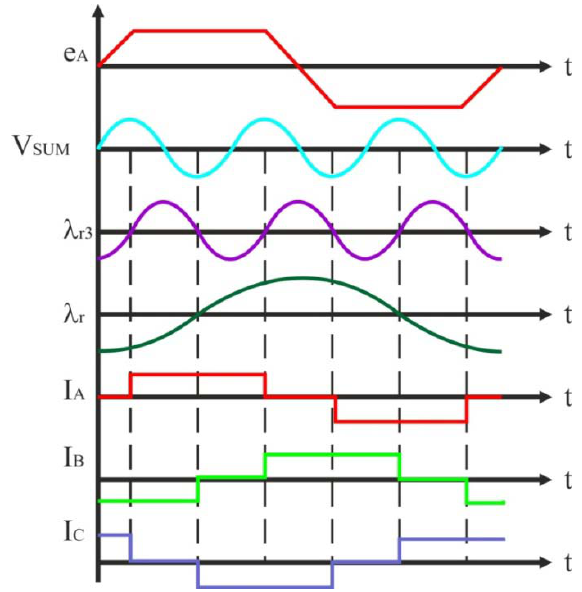
Figure 10. Back-EMF, third harmonic voltage, rotor flux and rotor flux fundamental components, and motor phase currents